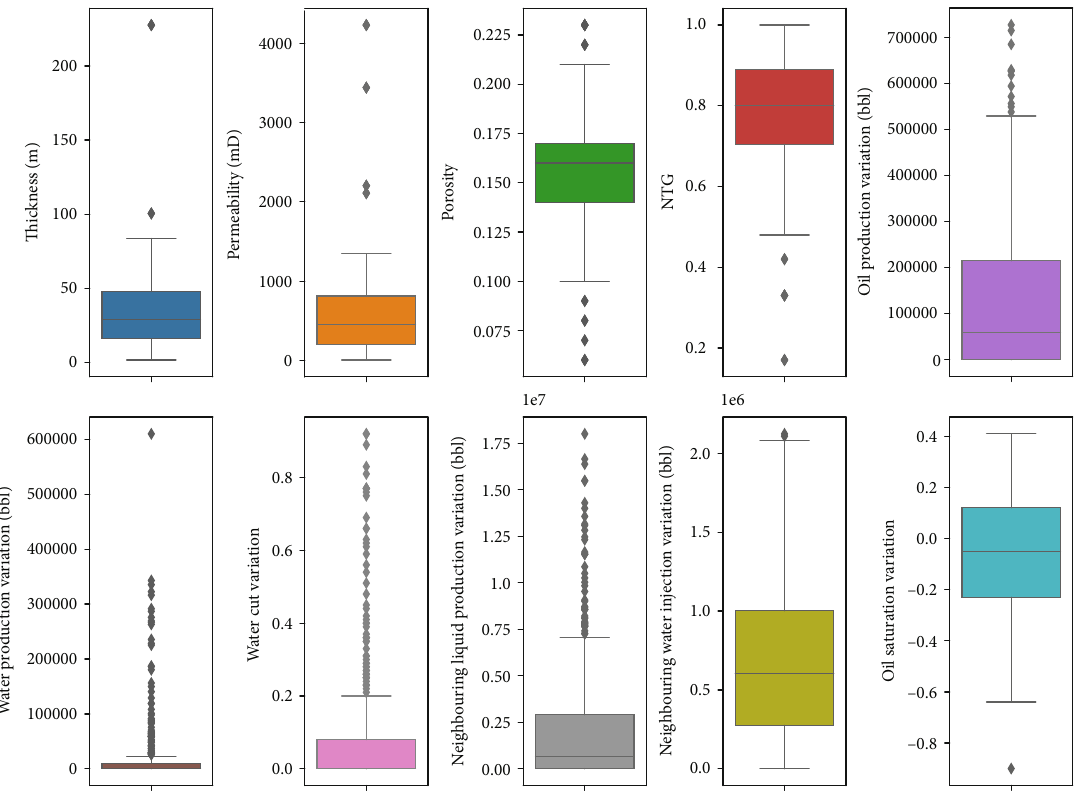
Figure 5: Outlier analysis using